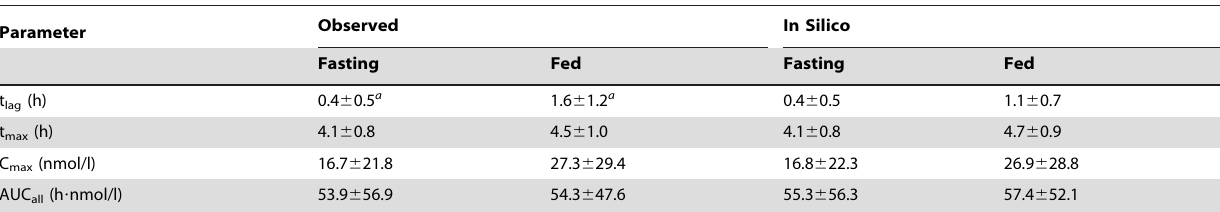
Table 3. Pharmacokinetic parameter